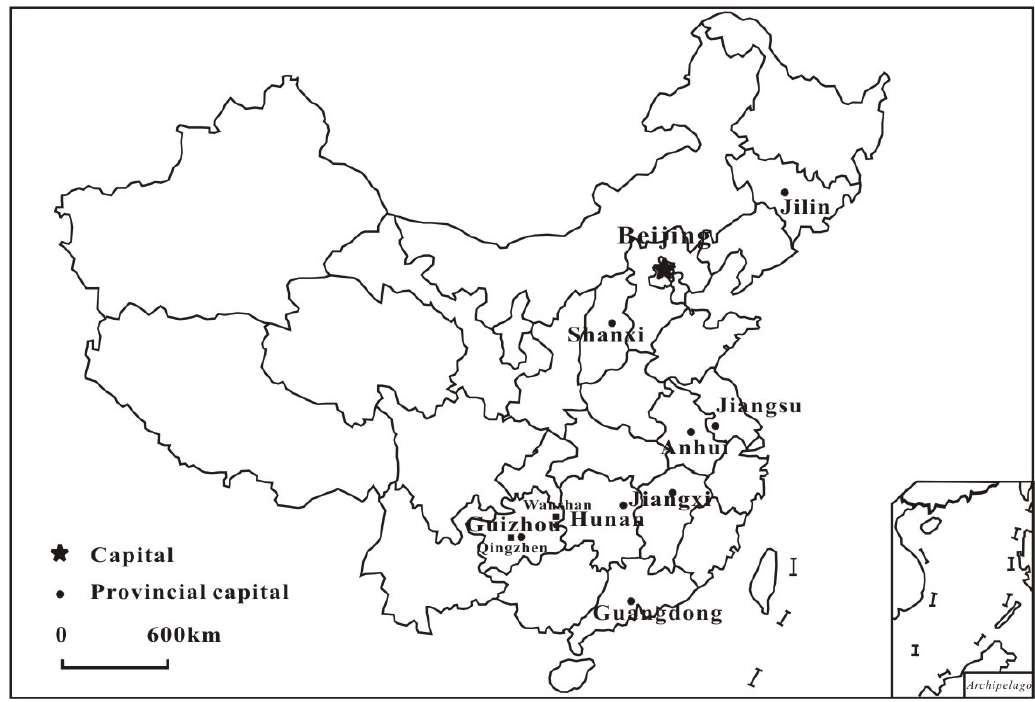
Figure 3. Location of sample sites of Se concentrations in rice from different provinces in